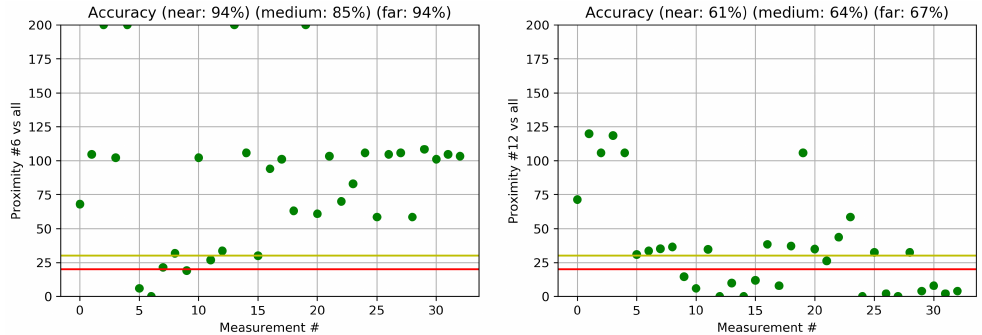
Figure 6. Proximity for outdoor measurements. The red and yellow lines are thresholds T1 and T2, and green dots denote proximity to location #6 ( left ) and #12 ( right ).